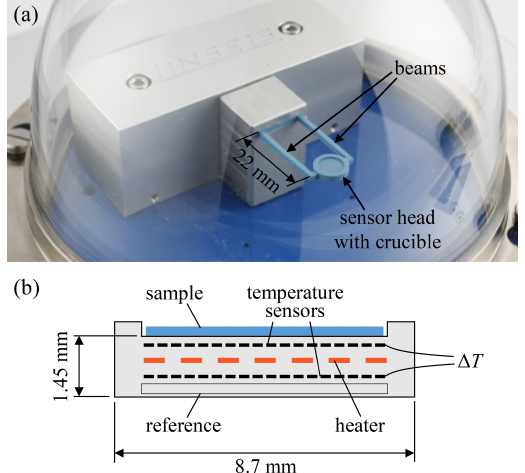
Figure 2. Ceramic differential scanning calorimeter chip (a) and cross section of the sensor head with functional elements (b) . The heater, temperature sensors, sample, and reference form a symmet- rical